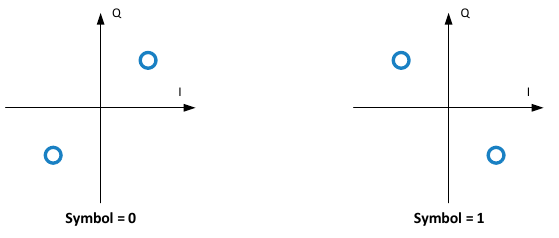
Figure 14. π /2 BPSK frame marker symbols.